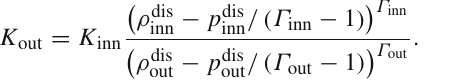
= 2 . 4, and two different values of out